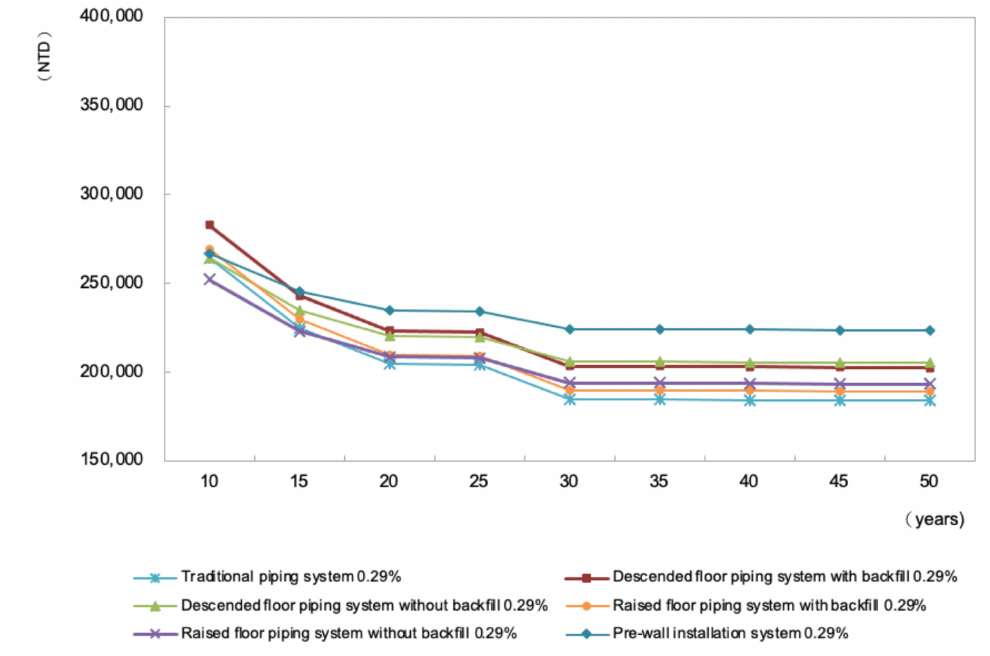
Figure 7. Life cycle costs for the partial replacement of pipelines in the four types of bathroom piping systems with discount rate of